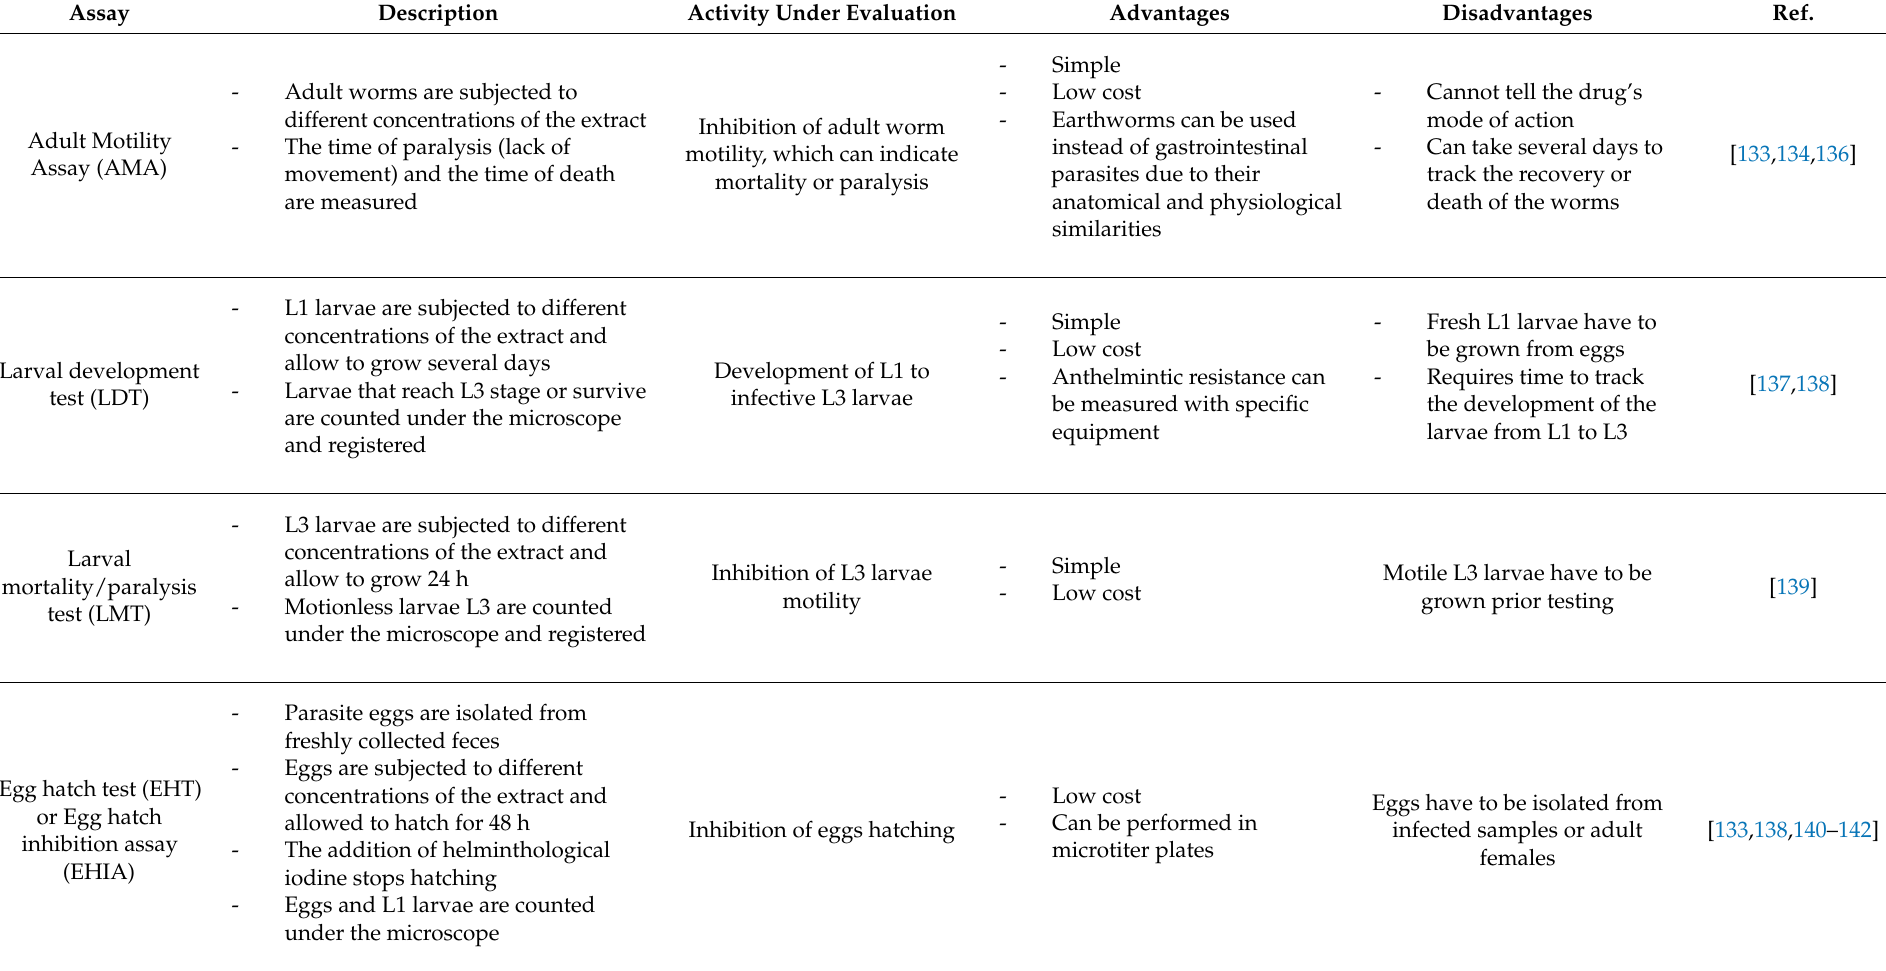
Table 3. Most common methods for in vitro determination of anthelmintic